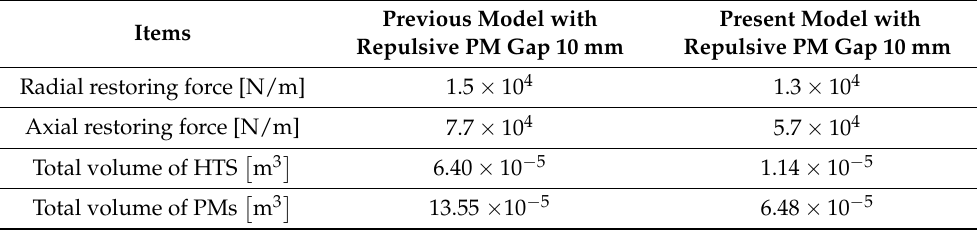
Table 3. Comparison with the results of previous research.